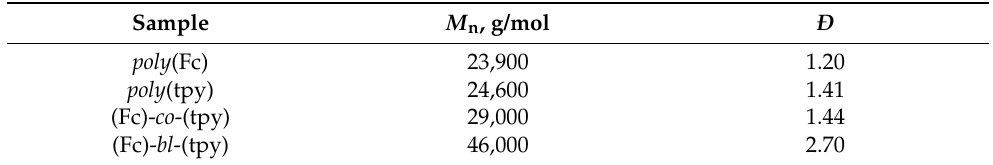
Figure 1. Schematic representation of the synthesis of four Fc- and/or tpy-containing polymers. Table 1. Summary of the SEC data: number-averaged molar mass ( M n ) and molar mass distribution (dispersity, Ð = M W / M n , where M W is the weight-averaged molar mass) 1 .